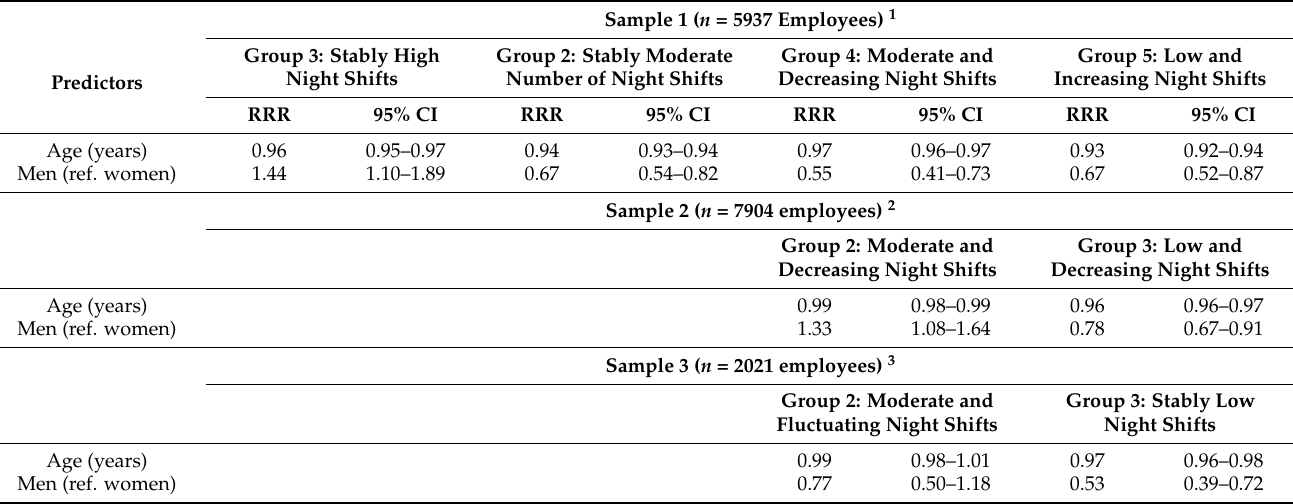
Table 4. Age and sex as predictors for night work